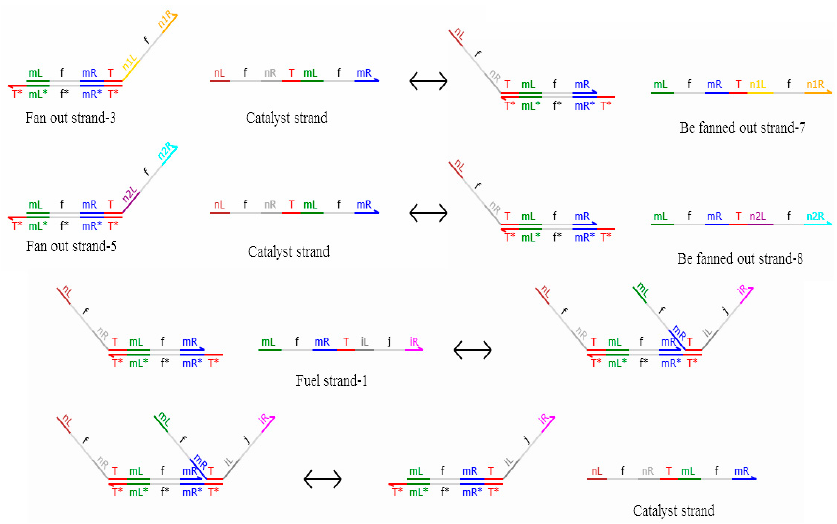
Figure 8. Reactions among fan out strand-3, fan out strand-5, and fuel strand-1.